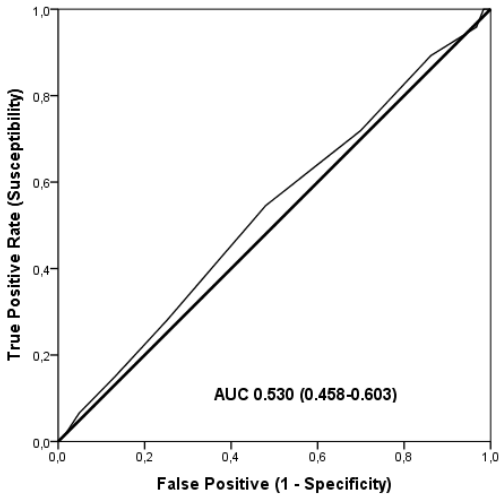
Figure 3. ROC analysis summarizing the ability of TGS to distinguish potential endurance elite athletes from non-athletes.